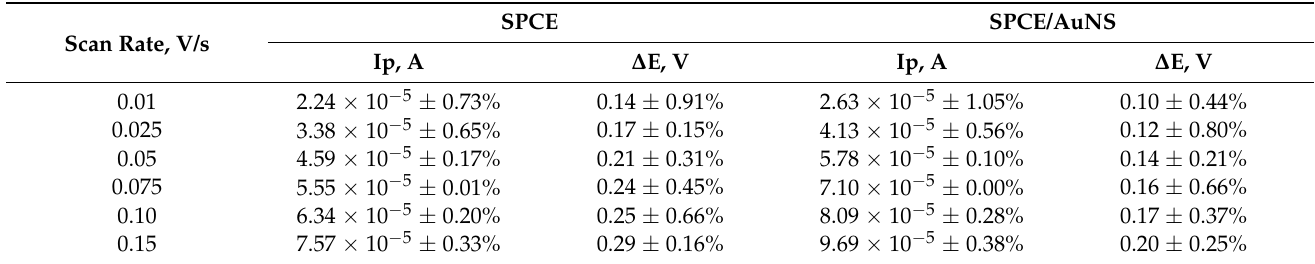
Table 1. Experimental data obtained from CV at different scan rates for SPCE and SPCE/AuNS. Error bars were calculated as a percentage of standard